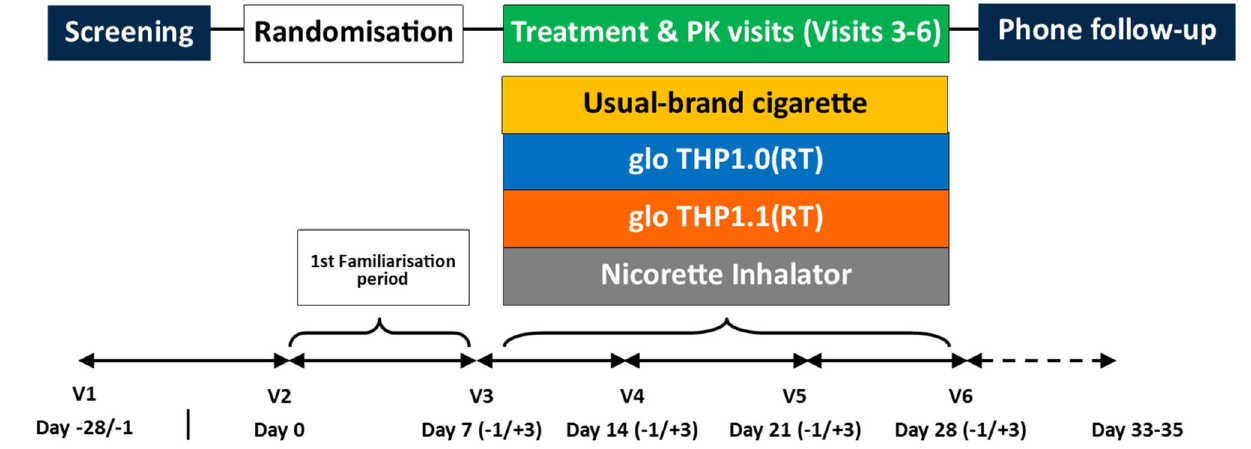
Figure 1. Schematic diagram of the study design.